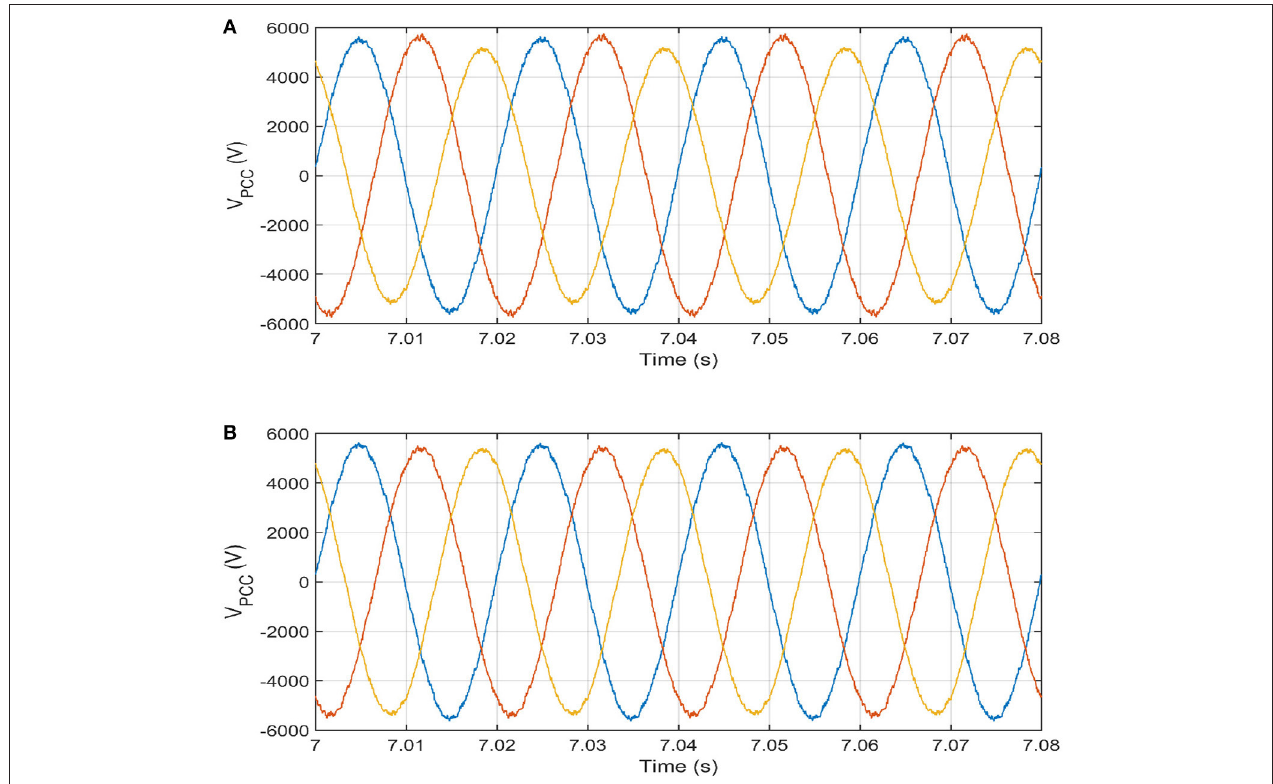
FIGURE 8 | Voltage waveforms before and after the activation for mitigation of voltage unbalance at 2nd unbalanced load (from t = 6 s to t = 8 s). (A) Voltage waveforms at PCC for 2nd unbalanced loads without mitigation. (B) Voltage waveforms at PCC for 2nd unbalanced loads with mitigation.